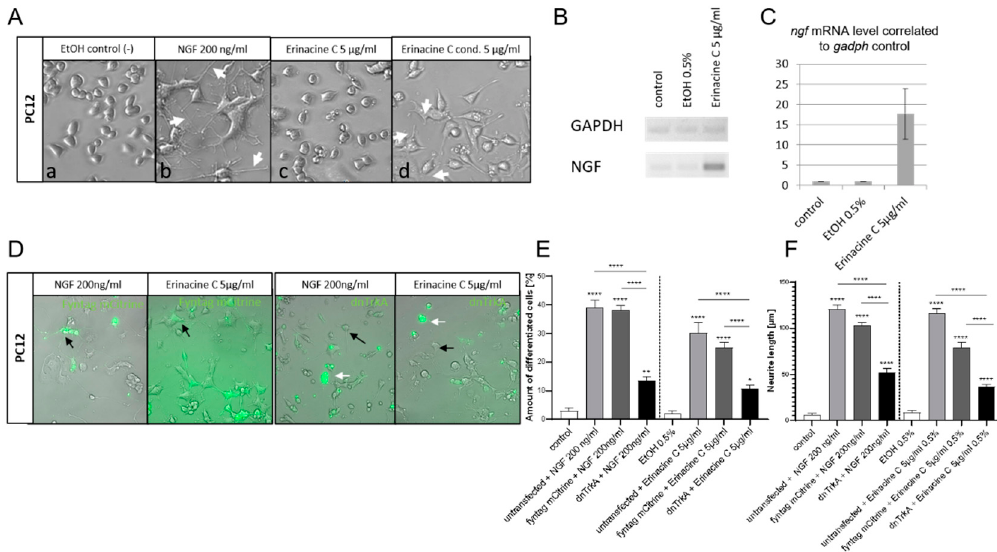
Figure 1. Erinacine C induces NGF expression in 1321N1 astrocytoma cells. ( A ) PC12 cells after 48 h of incubation in medium supplemented with ( a ) 0.5% EtOH, ( b ) 200 ng/mL of recombinant NGF, ( c ) 5 µg/mL erinacine C, ( d ) or maintained in medium conditioned by 1321N1 cells that were incubated with 5 µg/mL erinacine C. Neurite-like membrane protrusions as signs of PC12 differentiation are marked by white arrows. ( B ) PCR fragments after gel electrophoresis of semiquantitative RT-PCR samples to compare regulation of ngf expression in 1321N1 cells to the housekeeping gene gapdh under normal, 0.5% EtOH, and 5 µg/mL erinacine C conditions 48 h after onset of compound treatment. ( C ) Relative expression levels of ngf 1312N1 cells, EtOH controls and erinacine C exposed cells ( n = 3). ( D ) PC12 cells transfected with pCS-dnTrkA-Citrine (green fluorescence) treated with 0.5% EtOH, 200 ng/mL recombinant NGF or conditioned medium of 1321N1 cells incubated in 5 µg/mL erinacine C. While nonfluorescent and pCS-FynmCitrine transfected control cells are marked by black arrows, green fluorescent cells with impaired TrkA-signaling are marked by white arrows. The differentiation of PC12 cells was quantified regarding ( E ) the percentage of cells displaying membrane protrusions ( n = 3 independent cultures) and ( F ) the average length of neurite-like structures established by differentiating cells ( n = 180). * p < 0.05, ** p < 0.01, **** p < 0.0001. Scale bar: 100 µm.